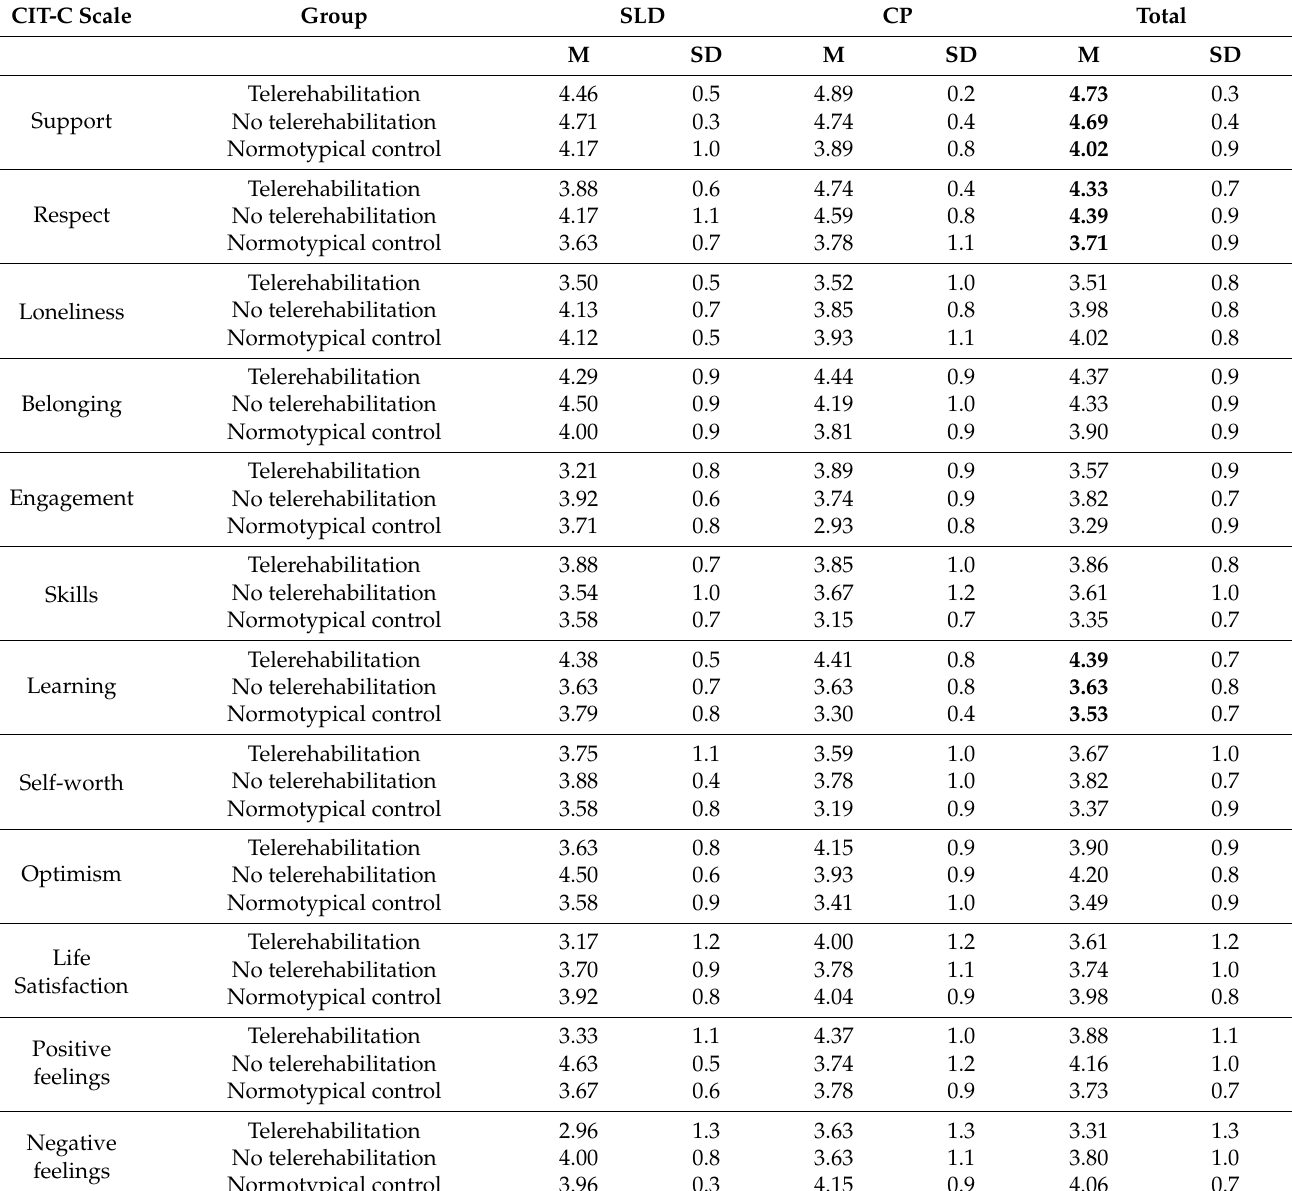
Table 2. CIT-C’s mean scores and SD of the three groups by diagnosis (significant differences in bold). CIT-C Scale